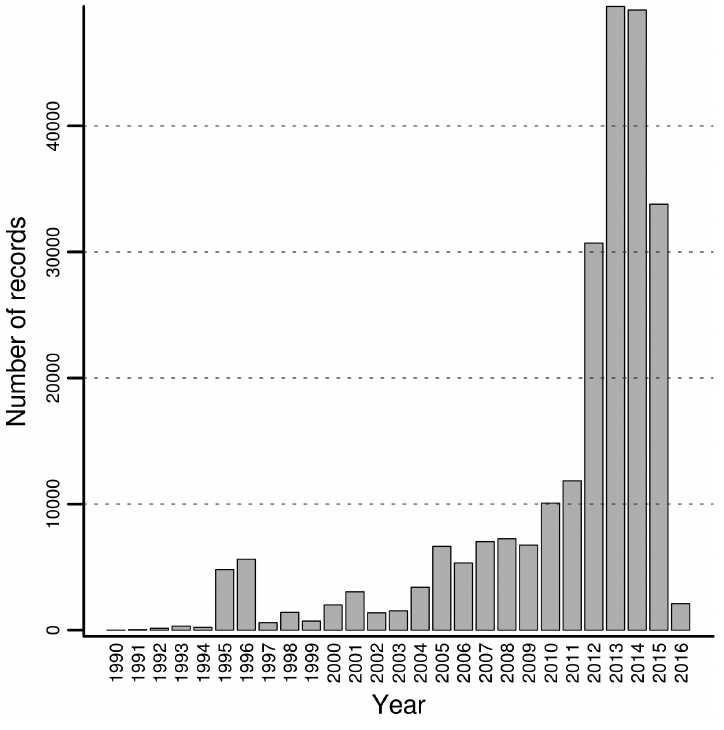
Figure 6. Barplot depicting the number of occurrence records observed per year. Occurrences observed before 1990 (127) were omitted for clarity. 7,681 records are not